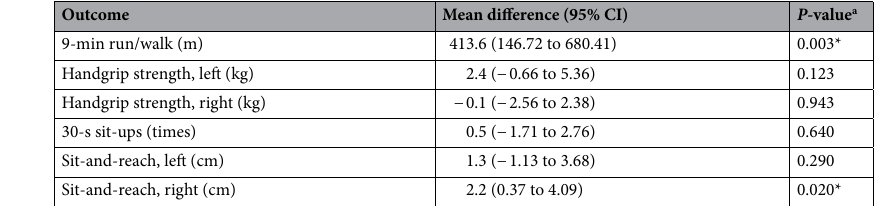
Table 3. Between-group differences in changes in outcomes from the pretest to the posttest. CI, Confidence interval. * p < 0.05. a Between-group difference is the mean change difference of the intervention group relative to the control group, which was calculated by the general linearmodel with the intervention group as the main effect; sex, the presence of comorbidities and the baseline value of outcome measures as covariates.